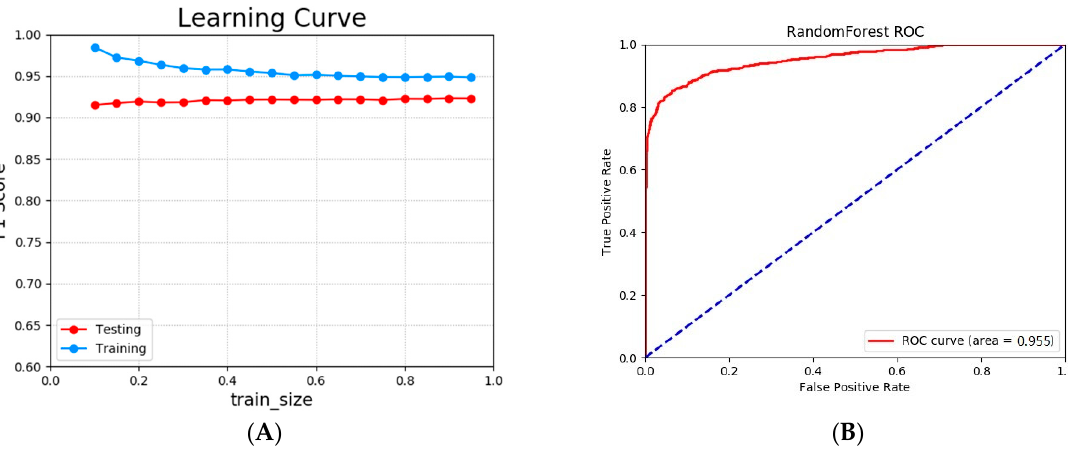
Figure 9. Learning curve ( A ) and ROC curve ( B ) of the Random Forest early-warning model.